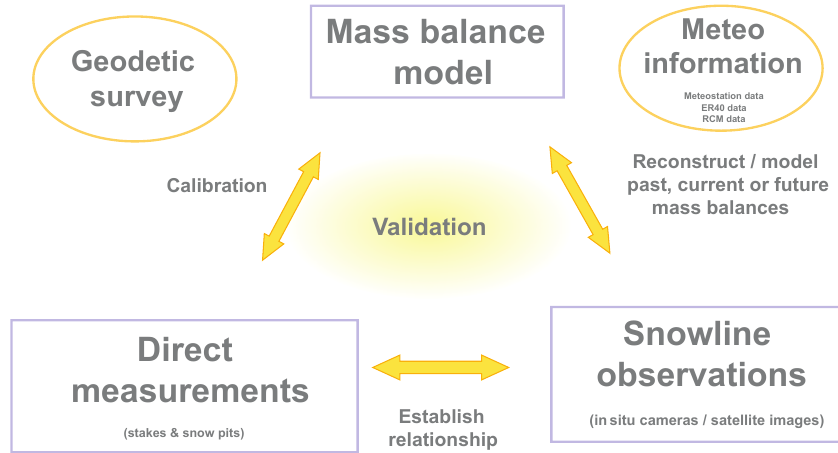
Figure 2. Schematic view of the monitoring strategy applied for re-established measurements in Central Asia.